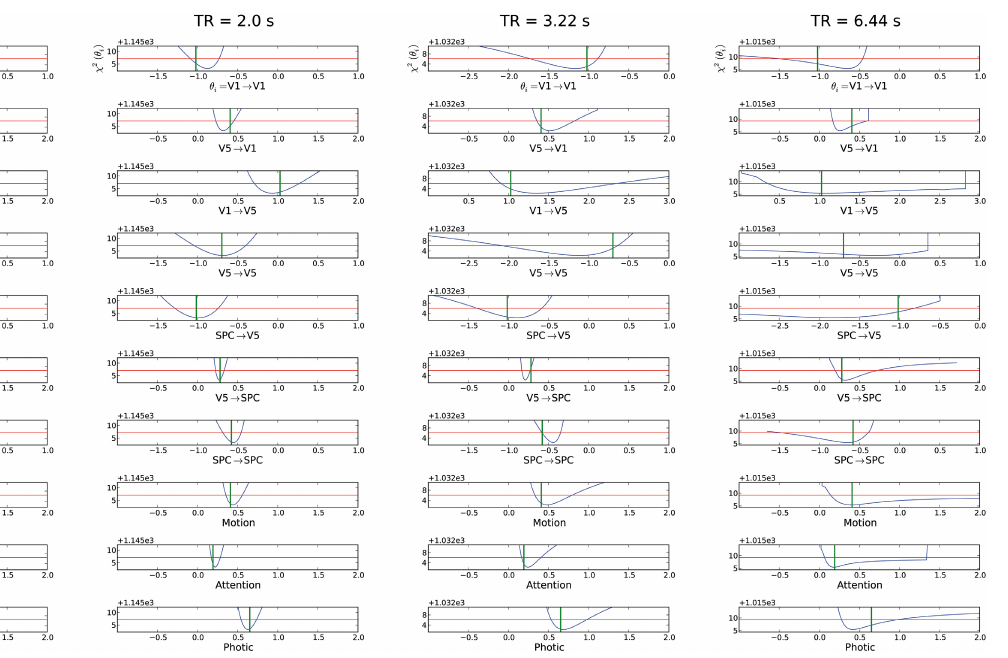
parameter value range. The y-axis depicts the χ 2 -value of the model fit (see definition of χ 2 in Section “Parameter Estimation”). This value describes the residual information of the data which cannot be explained by the model alone e.g., noise or residual information due to an improper model. Note that x-axis range can change across subplots to enable full depiction of confidence intervals, while the scaling does not change. For the mean confidence interval mCI we gained values 0.22, 0.29, 0.61, ∞ for a TR of 1 to 6.44s,